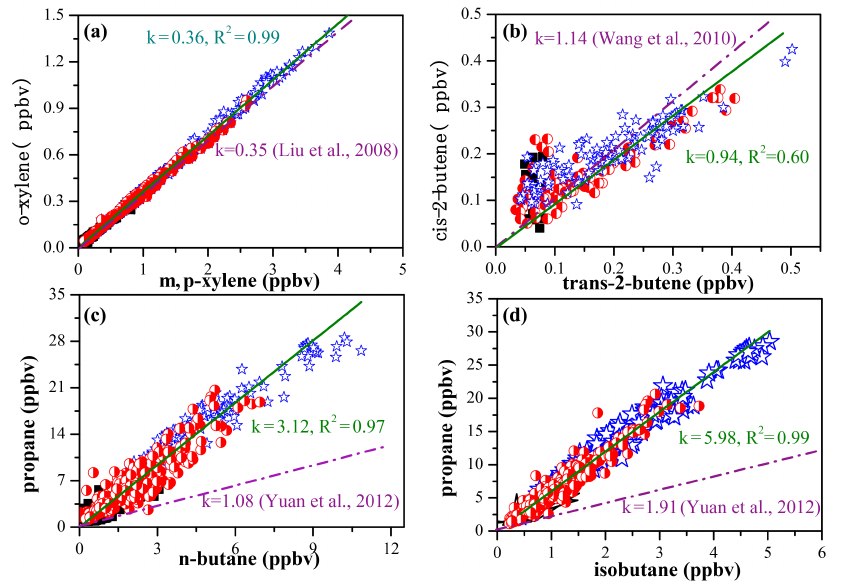
Figure 4. Ratios and linear correlation coefficients ( R 2 ) between (a) o-xylene and m,p-xylene, (b) cis-2-butene and trans-2-butene, (c) propane and n-butane, and (d) propane and isobutane during clear days (in black), light haze days (in red), and heavy haze days (in blue). Table 4. Emission ratios of NMHC pairs in Beijing and other regions and comparisons with vehicle emissions. This 43 Chinese Vehicle Beijing Pearl River Houston Mexico Northeastern Tokyo study cities emissions Delta City US Slope ( R 2 ) Slope a Ratio Slope b Ratio b Slope c Ratio d Ratio e Ratio Ratio